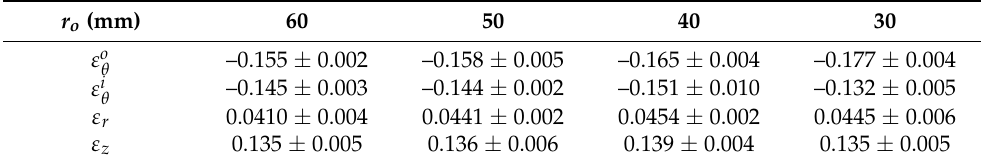
Table 3. Comparison of thermal strains with various outer radii ( r o ).